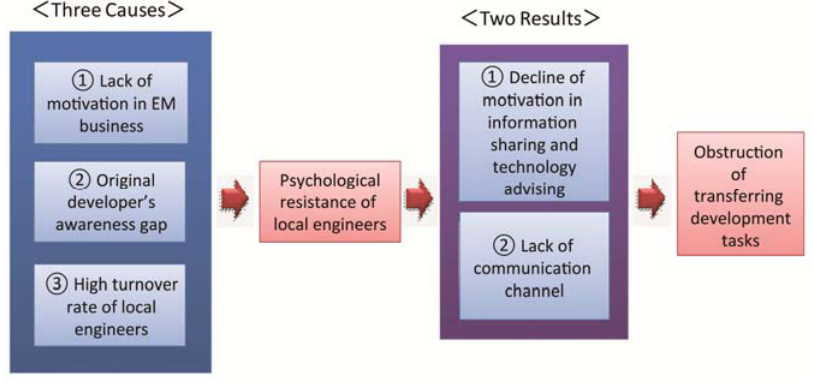
Figure 1. Psychological resistance of headquarter engineers: Causes and